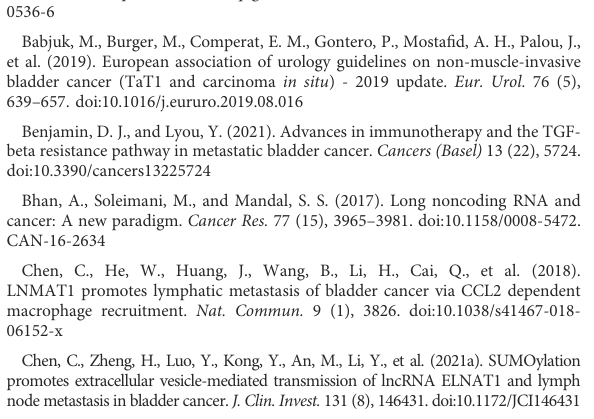
SUPPLEMENTARY FIGURE S1 Expression and gene mutation of necroptosis-related genes (NRGs). (A) The expression differences of NRGs between tumor and normal tissues. (B) The gene mutations of NRGs in muscle-invasive bladder cancer. SUPPLEMENTARY FIGURE S2 Identi fi cation of prognostic necroptosis-related lncRNAs (NLRs) by univariateCoxregressionanalysis. (A) TheforestplotofprognosticNLRs acquired through univariate Cox regression analysis. (B) The heat map of prognostic NLRs extracted by univariate Cox regression analysis. SUPPLEMENTARY FIGURE S3 SurvivalandimmunefunctionsoftwoclustersbasedonprognosticNLRs. (A) MIBCpatientsweredividedintotwoclustersbyconsensusclustering analysis. (B) Kaplan – Meier curve of OS in clusters. (C – E) The comparison of stromal score, immune score, and ESTIMATE score in two clusters. SUPPLEMENTARY FIGURE S4 PCA analysis of patients in two clusters and risk groups. (A) Cluster. (B) Risk. SUPPLEMENTARY FIGURE S5 ROC curves of risk score and other clinical features. (A) 2 years. (B) 3 years. SUPPLEMENTARY FIGURE S6 Histogram showing the difference of risk scores in muscle-invasive bladder cancer (MIBC) patients strati fi ed by clinical features. (A) T stage. (B) N stage. (C) M stage. (D) Age. (E) Gender. SUPPLEMENTARY FIGURE S7 Functional analyses and tumor mutation burden (TMB). (A) Activated pathways analyzed by gene set enrichment analyses (GSEA) in the low- risk group. (B) Gene Ontology (GO) analysis of differential genes between high- and low-risk groups. (C) The differences in TMB between high- and low-risk